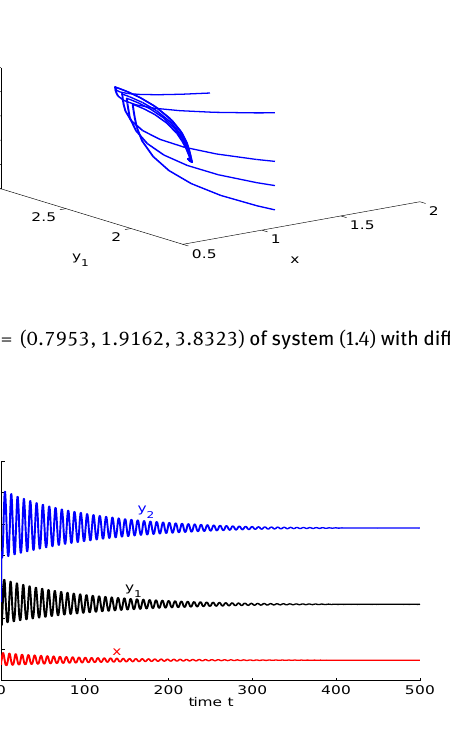
Figure 7: τ = 0.9 < 0.9429 = τ 0 , µ = 36 , E * = (0.1302, 0.4868, 0.9735) of system (1.4) is locally asymptotically stable, system (1.4) undergoes a Hopf bifurcation at E * when τ